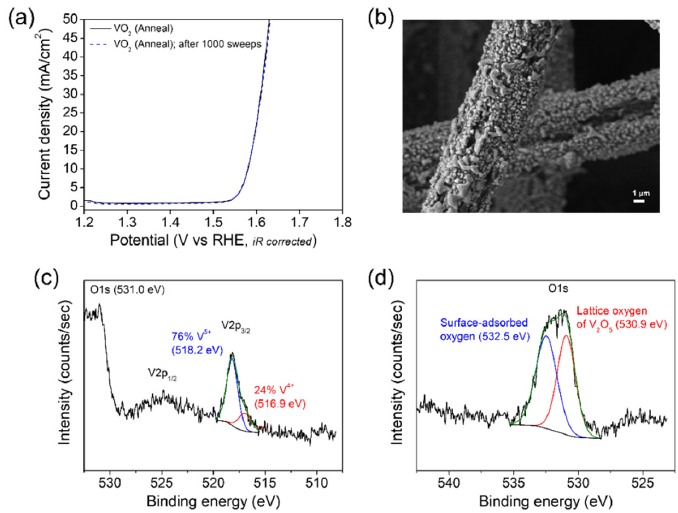
Figure 4. ( a ) Polarization curves of the VO 2 (M1) nanoparticles prepared by the vacuum annealing on CFP recorded before and after 1000 CV sweeps in a 1 M aqueous solution of KOH. ( b ) FESEM image acquired for the VO 2 (M1) nanoparticles after 1000 CV sweeps. XPS spectra of ( c ) V 2p and ( d ) O 1s acquired for the surface of the VO 2 (M1) catalyst after OER under a constant voltage of 1.6 V versus RHE for 30 min in a 1 M KOH electrolyte solution on the headspace of the electrocatalytic cell sealed under an Ar ambient with a three-electrode